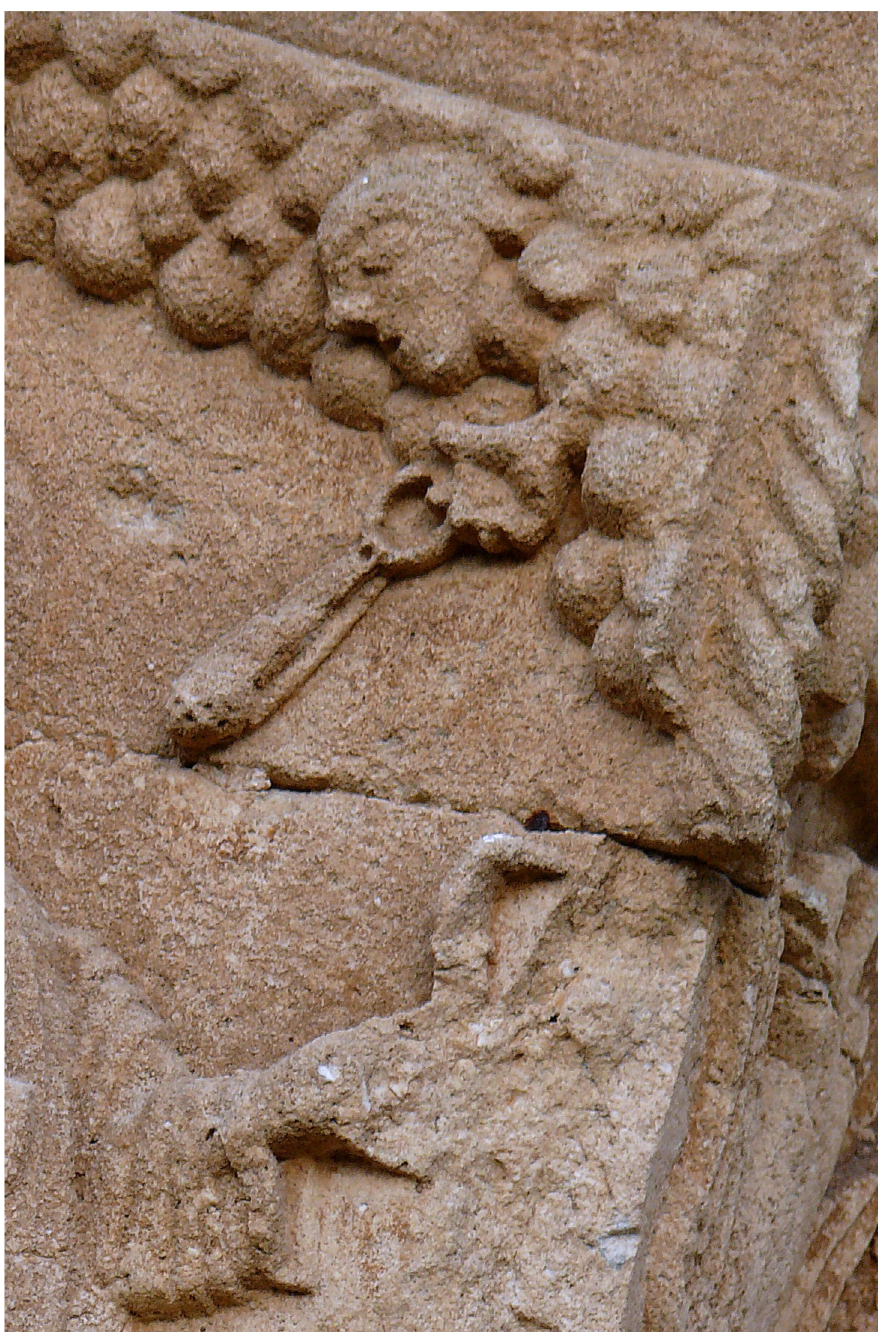
Figure 22. The prophet Isaiah and a seraph, detail of archivolt, west façade, Saint-Martin Church , 12th c., Besse, Dordogne, Nouvelle-Aquitaine, France. ©Author.